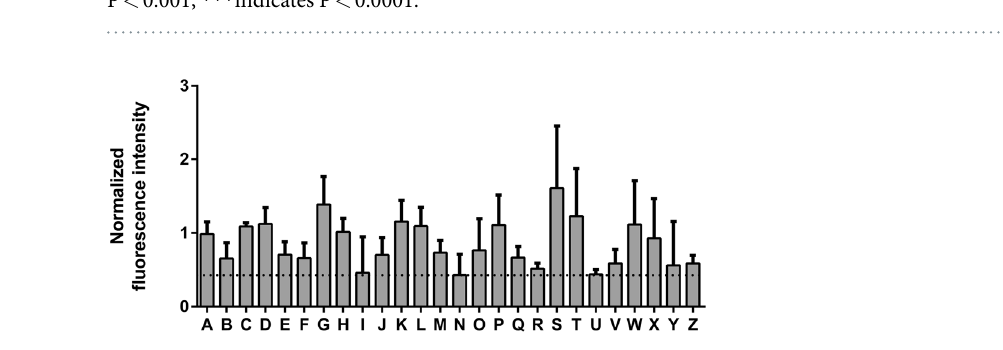
Figure 3. Normalized fluorescence intensity after incubation of clinical S. aureus isolates. A/Z indicate the isolates that were incubated. The dotted horizontal line represents the positive cutoff. Bars indicate mean fluorescence. Capped lines indicate standard